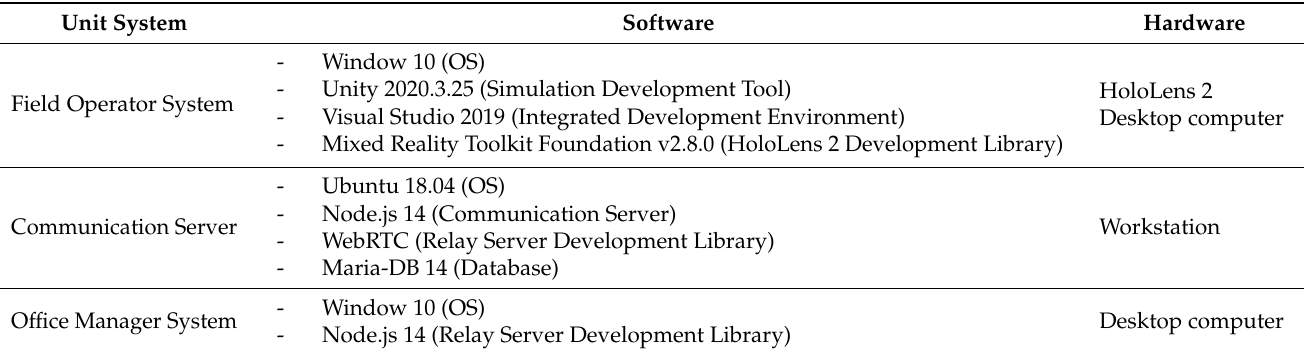
Table 1. System Development